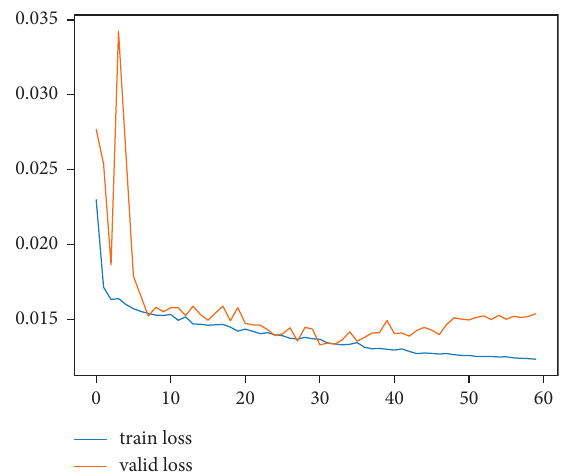
Figure 5: A typical FEB-LCR-ACM training loss curve for